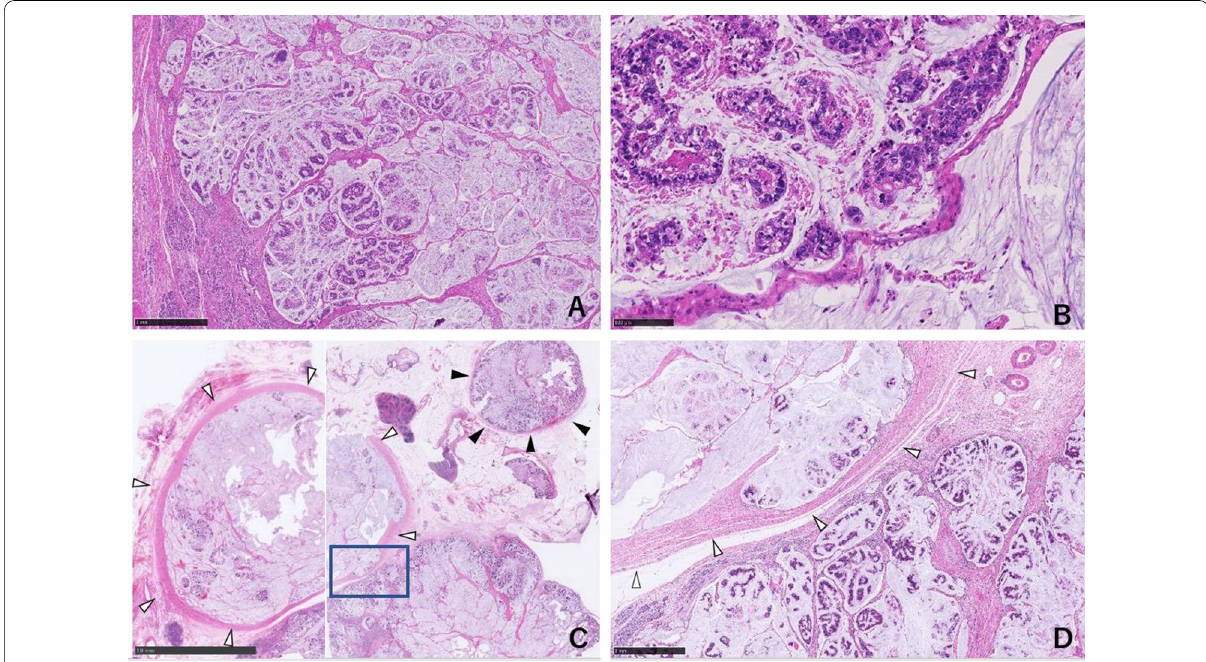
Fig. 8 Pathological findings. a Medium magnification image: abundant mucus and cell mass floating in the mucus lake are recognized. b High-magnification image: cells with densely stained and swollen irregular nuclei form clumps and float with some connectivity. This is a finding of colloid cancer. c Portal vein: the portal vein (white arrowheads) was full of tumor, and the small vessel around the tumor (black arrowheads) was also full of tumor. d The high-magnification image of c (rectangle). There was no distinct evidence of the tumor directly involving into the portal